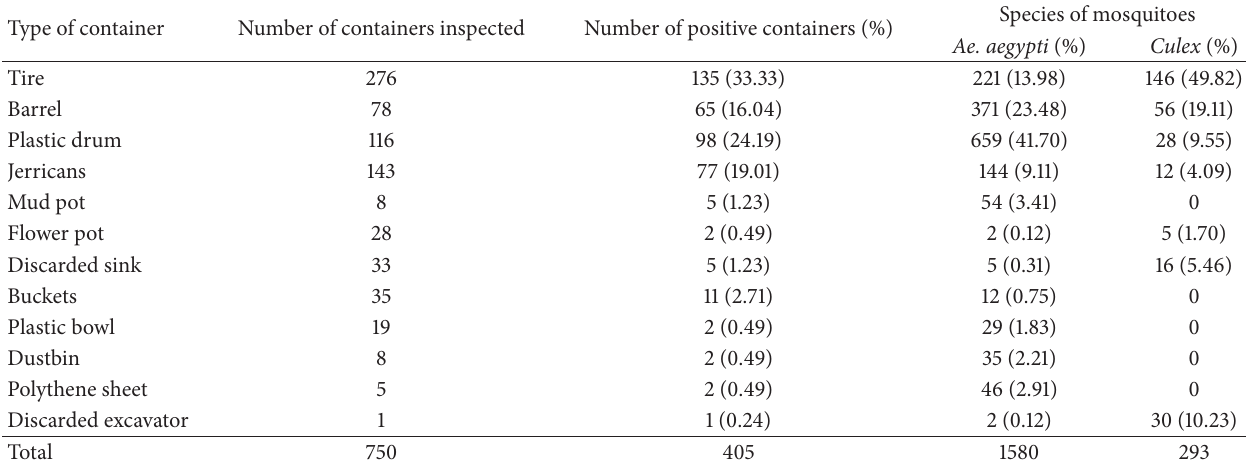
Table 2: Mosquitoes identified from larvae collected from artificial containers in Dire Dawa. Type of container